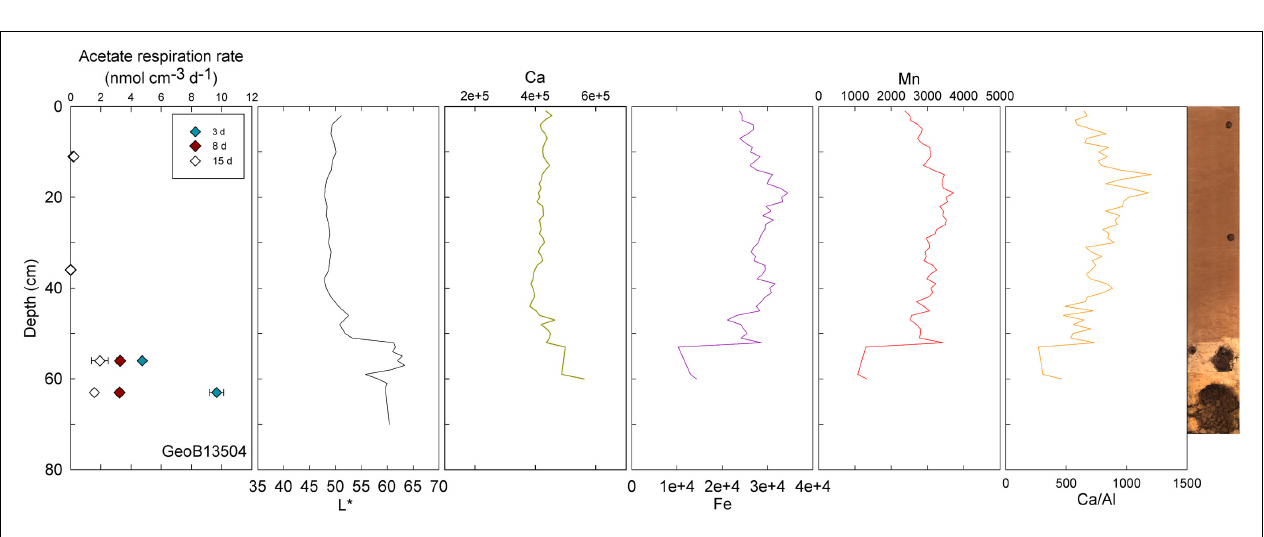
characteristic of the sediment–basalt transition beginning at ∼ 52cm. Micro-fragments of basalt are present in the lower clay-rich